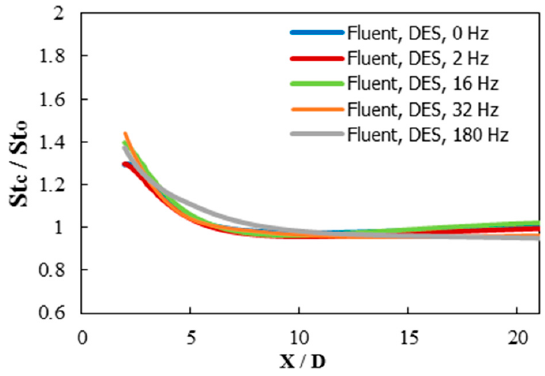
Figure 40. The centerline Stanton number ratio obtained using the DES Realizable k - ε model for M = 0.5 for the 0, 2, 16, 32, and 180 Hz oscillations.